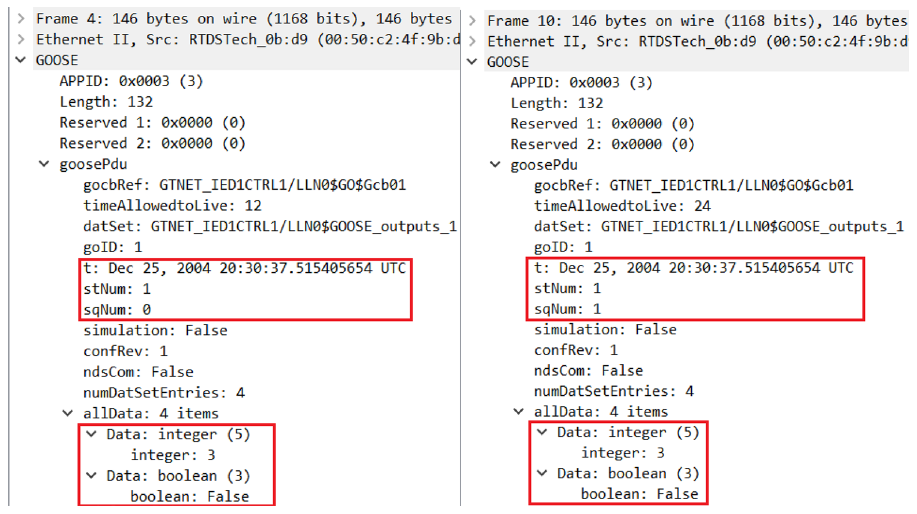
Figure 12. Original GOOSE packets for IED 1 on LAN port with sequence content